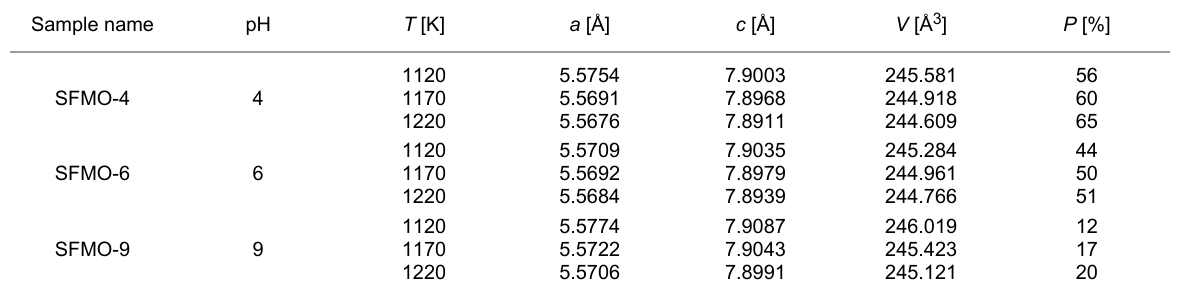
Table 1: Crystal lattice parameters and degree of superstructural ordering of Fe/Mo cations of SFMO-4, SFMO-6, and SFMO-9 powder samples annealed for 4 h at 1120, 1170, and 1220